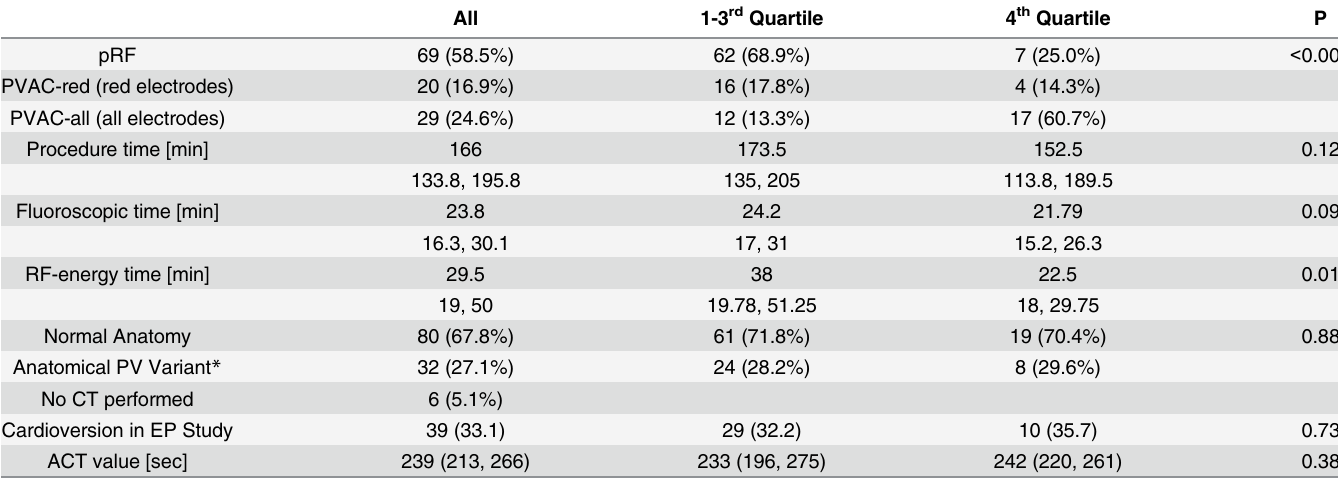
Table 2. Procedural